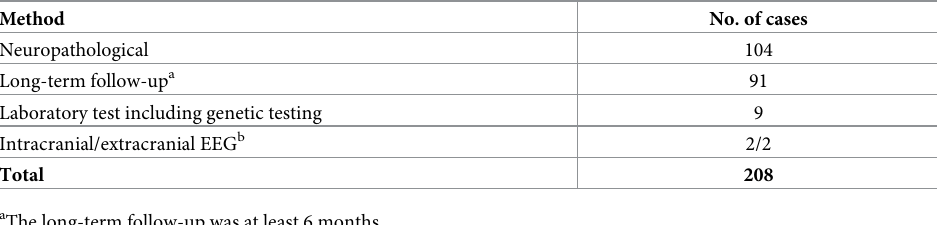
Table 2. Confirmation of the definitive